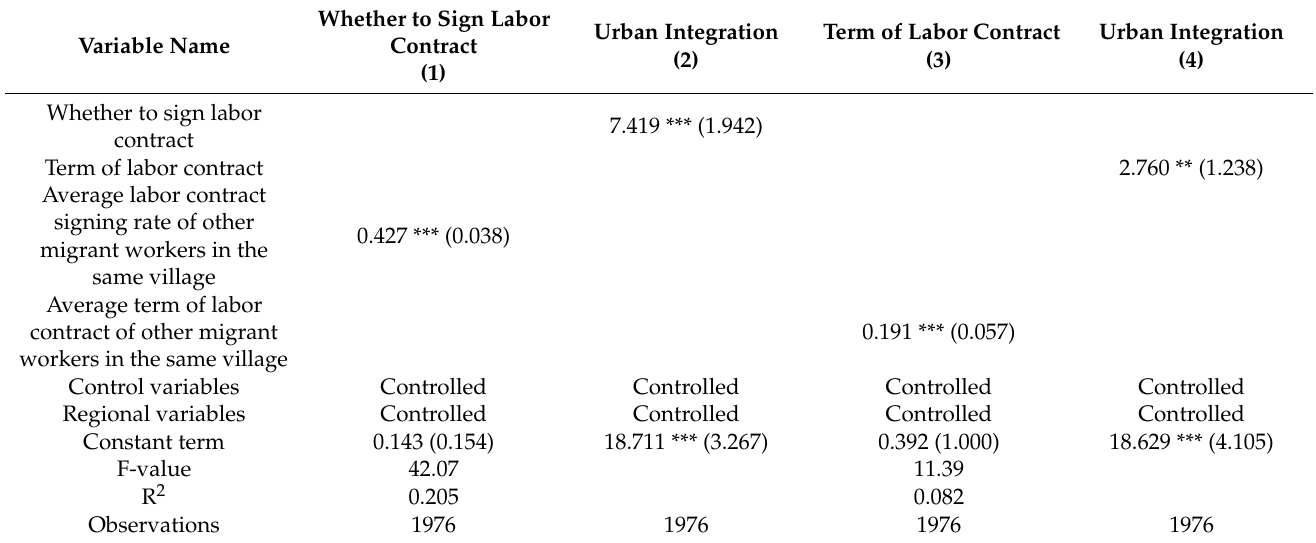
Table 4. 2SLS estimation results of labor contract and urban integration of migrant